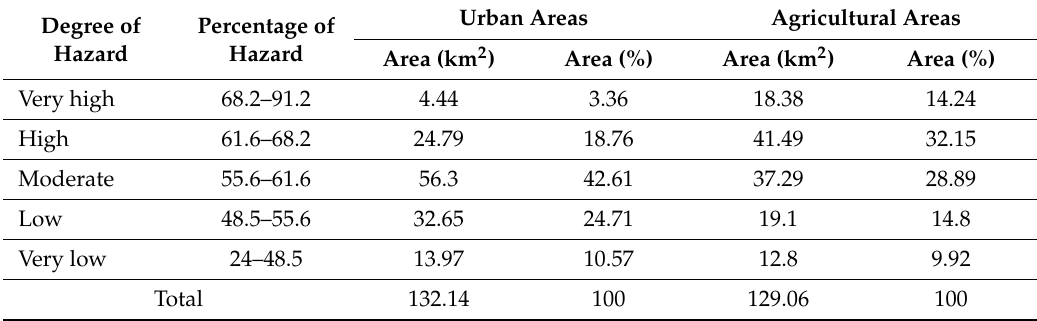
Figure 13. Degrees of flood hazard for urban and agricultural areas in the study area in 2020. Table 20. Degrees of flood hazard for urban and agricultural areas exposed to flood hazards in the study area in